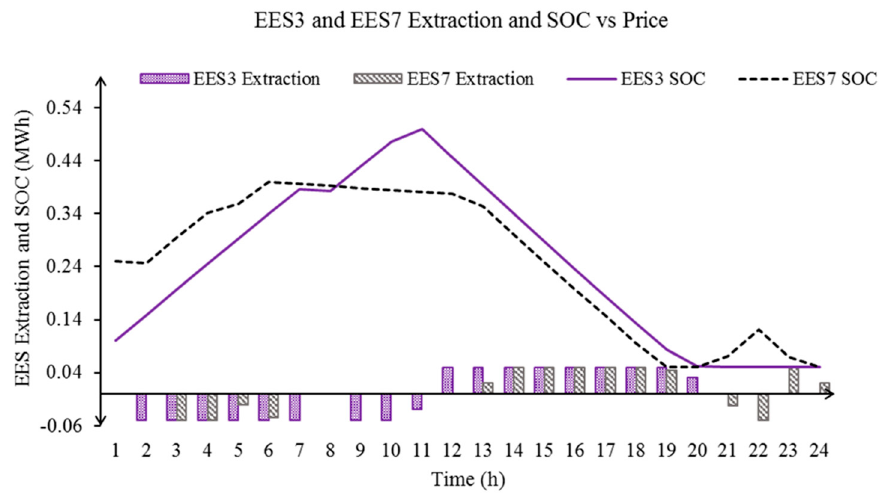
Figure 13. EES injection/extraction with 2-h minimum charging/discharging constraint.